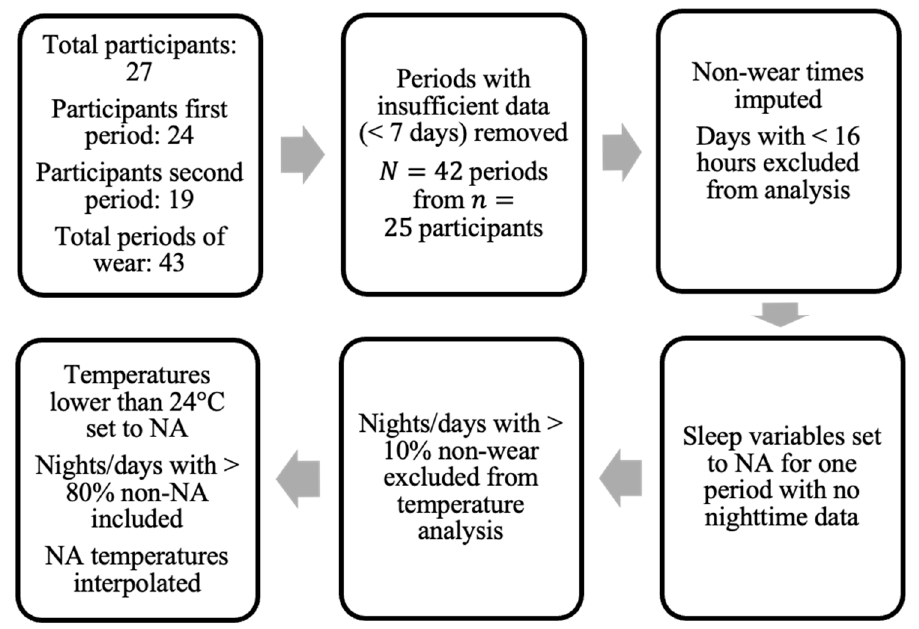
Figure 1. Flow-chart of data pre-processing. “Periods” denote separate treatment periods where data was collected ( 𝑁 = 42 ) from 𝑛 = 25 participants in the study.